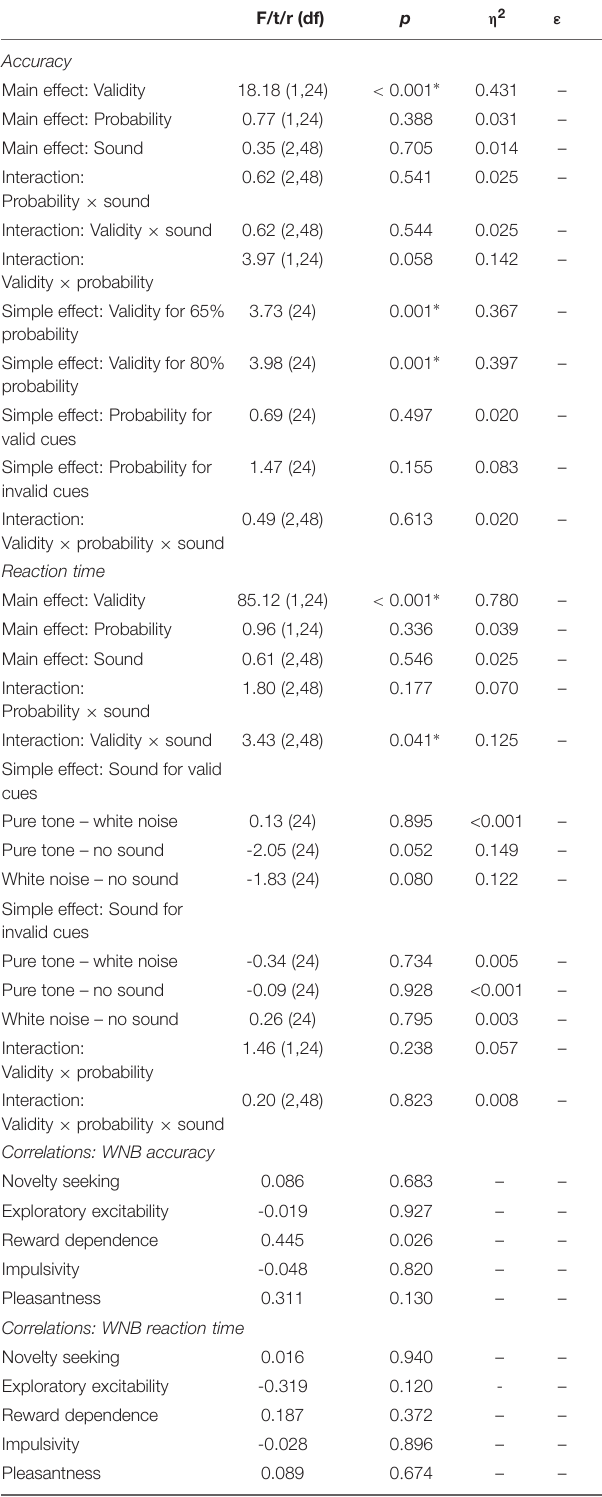
TABLE 5 | Statistics for Experiment